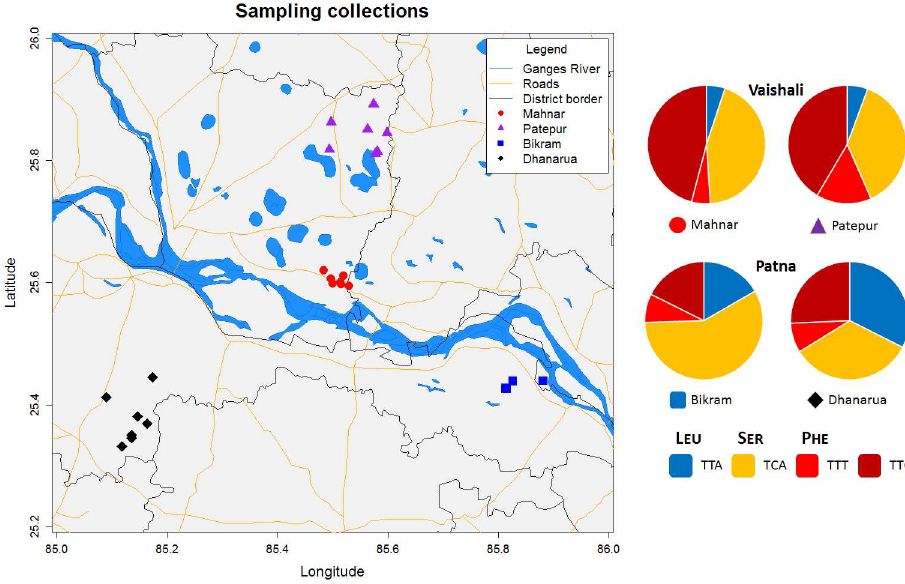
Fig 3. Primary health centre (PHC) collection locations and Vgsc -1014allele frequencies within Vaishali and Patna districts (north and south of River Ganges, respectively). Map displayedby the R- package“maps” with shapefiles stored in DIVA GIS website